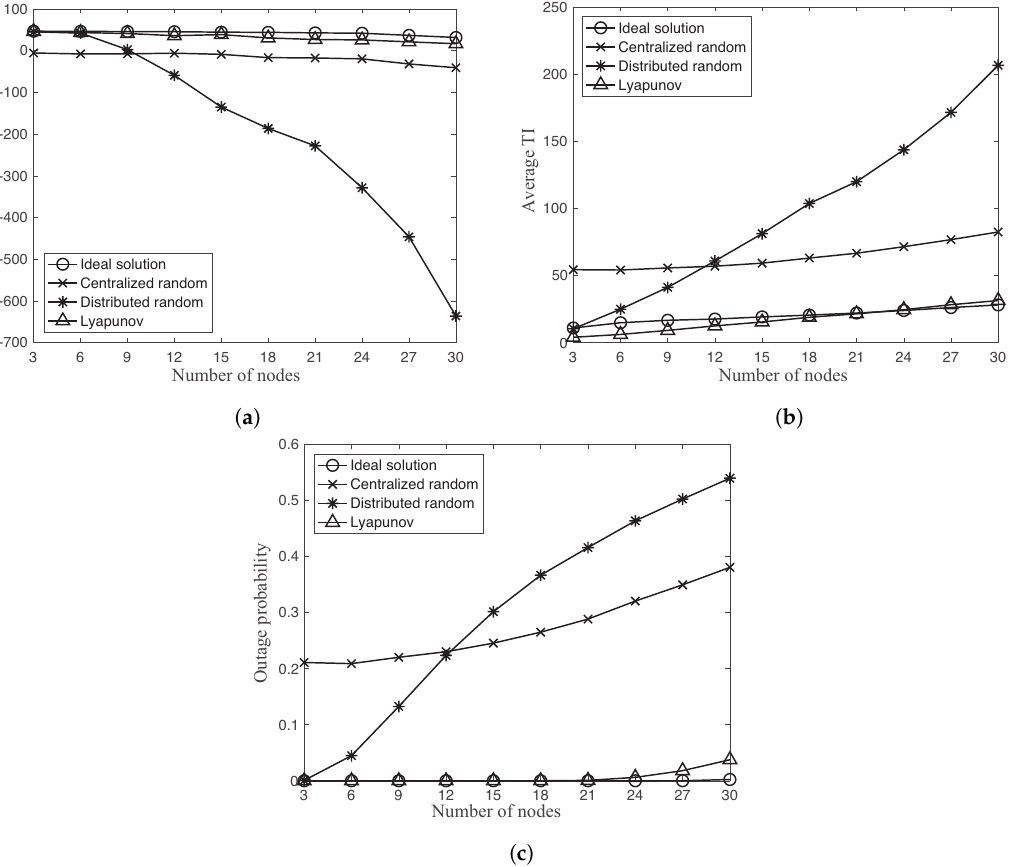
Figure 7. Minimum slack, average TI, and outage probability of ideal solution, centralized random access, distributed random access, and Lyapunov-based approach as a function of different number of nodes N = 3, . . . ,30: ( a ) minimum slack vs. number of nodes; ( b ) average TI vs. number of nodes; and ( c ) outage probability vs. number of